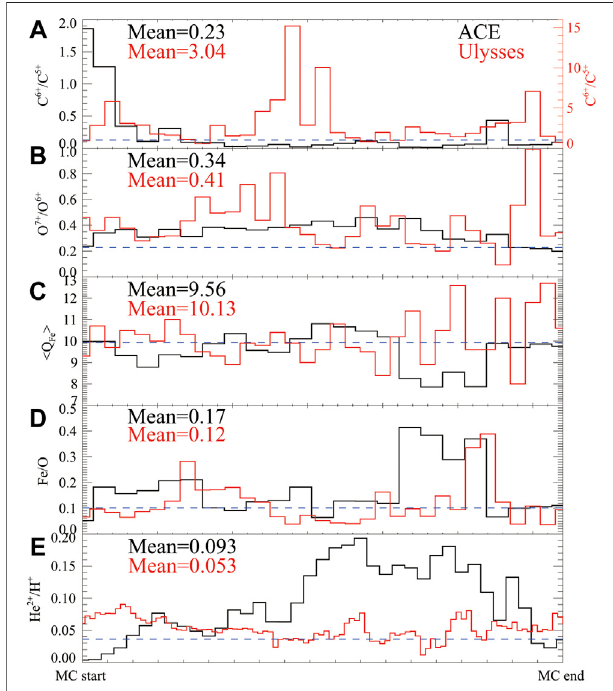
FIGURE4| CompositionwithintheMCprovidedbySWICSaboardACE (black) and Ulysses (red). Panels (A – E) show the C 6+ /C 5+ , O 7+ /O 6+ , < Q Fe > , Fe/O,andHe 2+ /H + sequentially,andtheiraveragevaluesarealsopresentedin each panel. Note that the Ulysses values in Panel (A) correspond to the right ordinate. The blue horizontal dashed lines depict the corresponding means of slow wind during solar maximum [65]. The MC started from 14:30 UTonMarch 4(3:00 UTonMarch 24)andended at 5:30UTonMarch 6(4:00 UT on March 28) for ACE